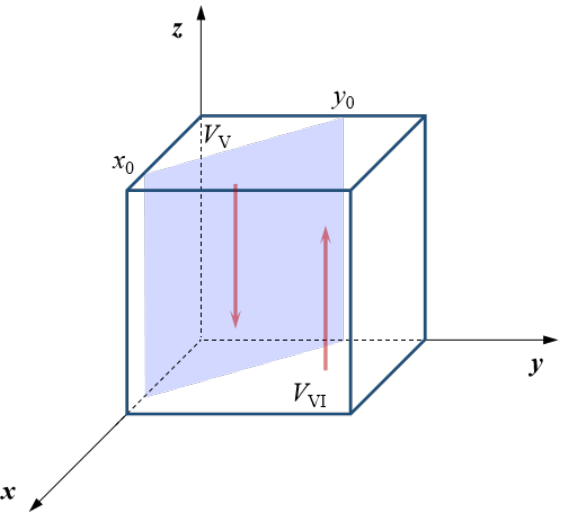
Figure 4. Evolutionary p hase diagram of the central government’s strategy.